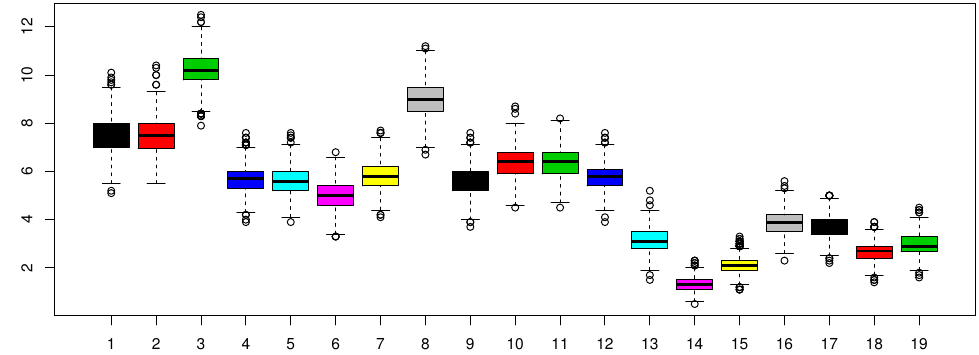
Figure 5. Lombardy, bootstrapped observations referring to 1986. Distribution of the number of meteorological stations in each of the 19 temperature classes.